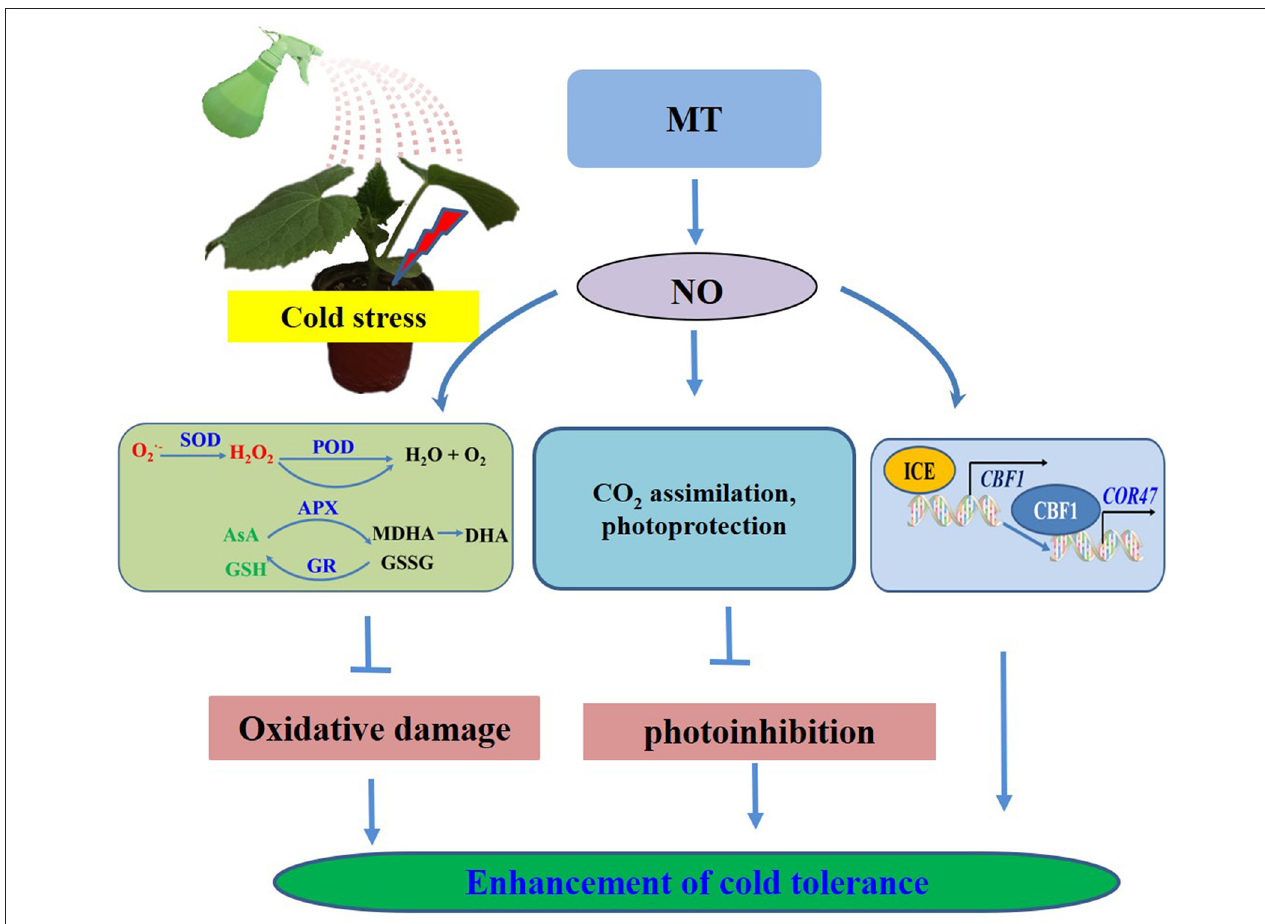
FIGURE 12 | Simplified schematic model for MT-induced cold tolerance in cucumber.